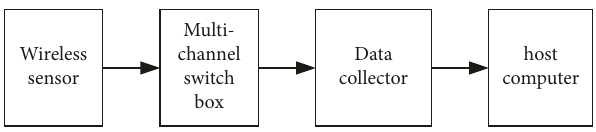
Figure 1: Hypocenter location system architecture for